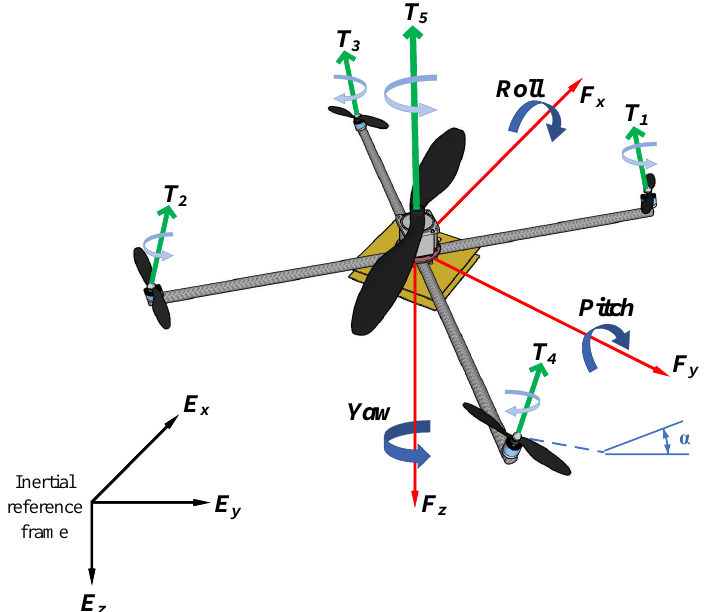
Figure 1. Heterogeneous multirotor